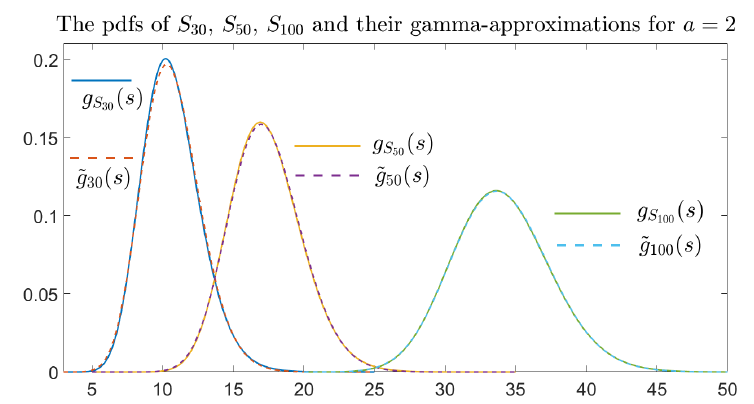
is n + a − β n = n a +1